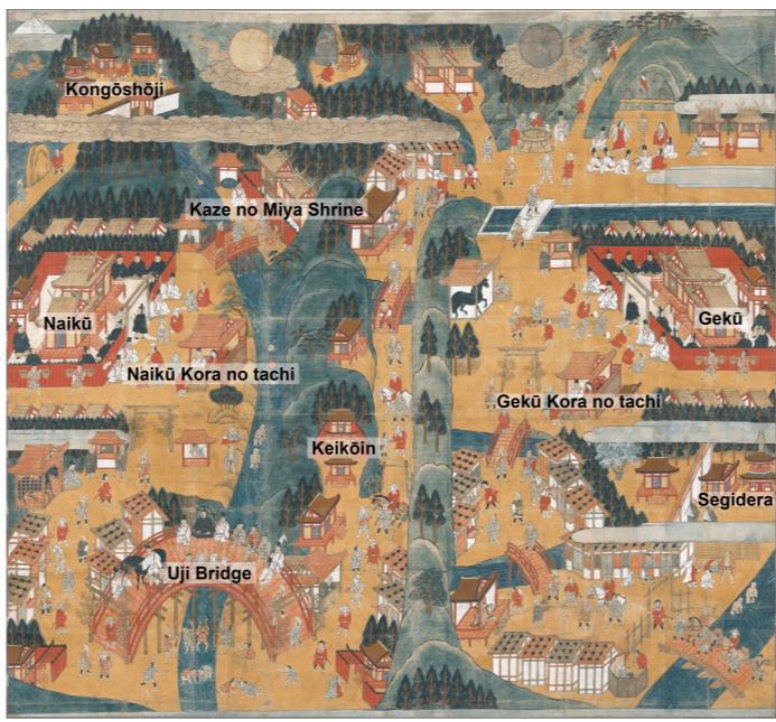
Figure 13. Labeled Ise Pilgrimage Mandala.